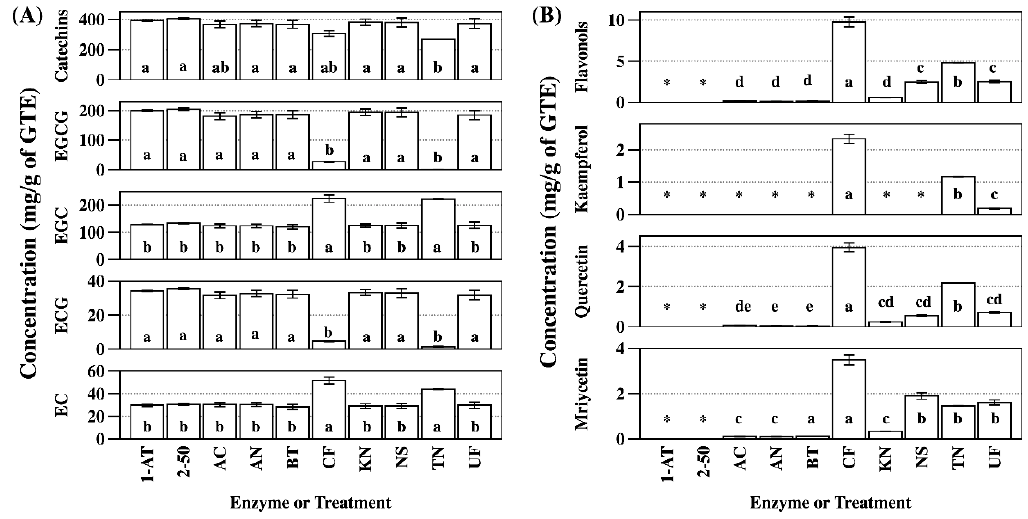
Figure 2. Changes of ( A ) catechins and ( B ) flavonols by the hydrolysis of cellulolytic enzymes. Data shown are the mean ± standard error of the mean (SEM) (mg/g GTE). Different letters on the bars indicate significant differences according to Tukey-Kramer’s honestly significant difference test ( p < 0.05). * means not detected. Flavonols represent the sum of myricetin, quercetin, and kaempferol. Catechins in Y-axis of ( A ) represent the sum of EC, ECG, EGC, and EGCG. 1-AT, control ambient temperature; 2–50, control 50 ° C; refer to the abbreviations of enzymes in Table 1. The numeric data are presented in Tables S1-S2.